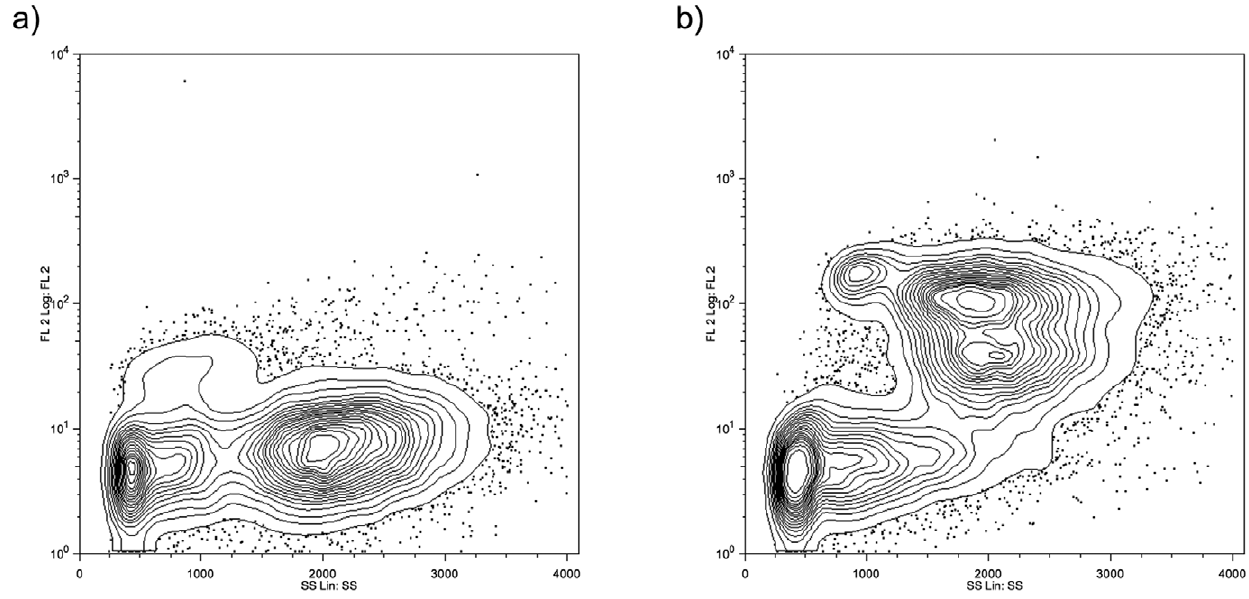
Figure 2. Flow cytometry graphic measuring phagocytic activity in a representative case of type 2 diabetic patient before (a) and after (b) 5-day intensification treatment of blood glucose.